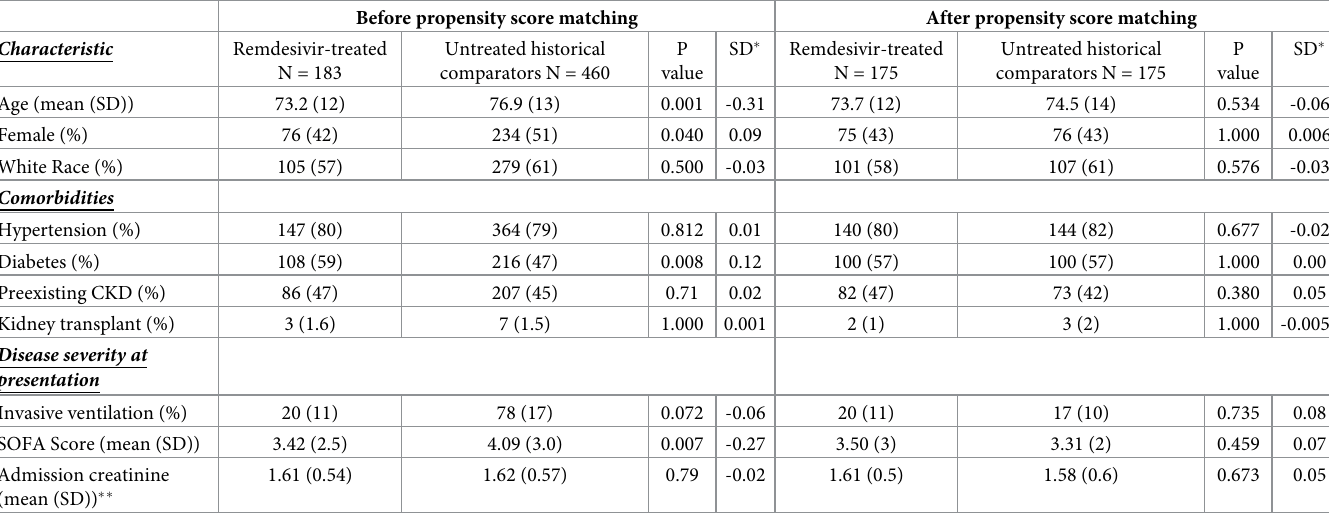
Table 1. Patient characteristics pre- and post-propensity score matching. Before propensity score matching After propensity score